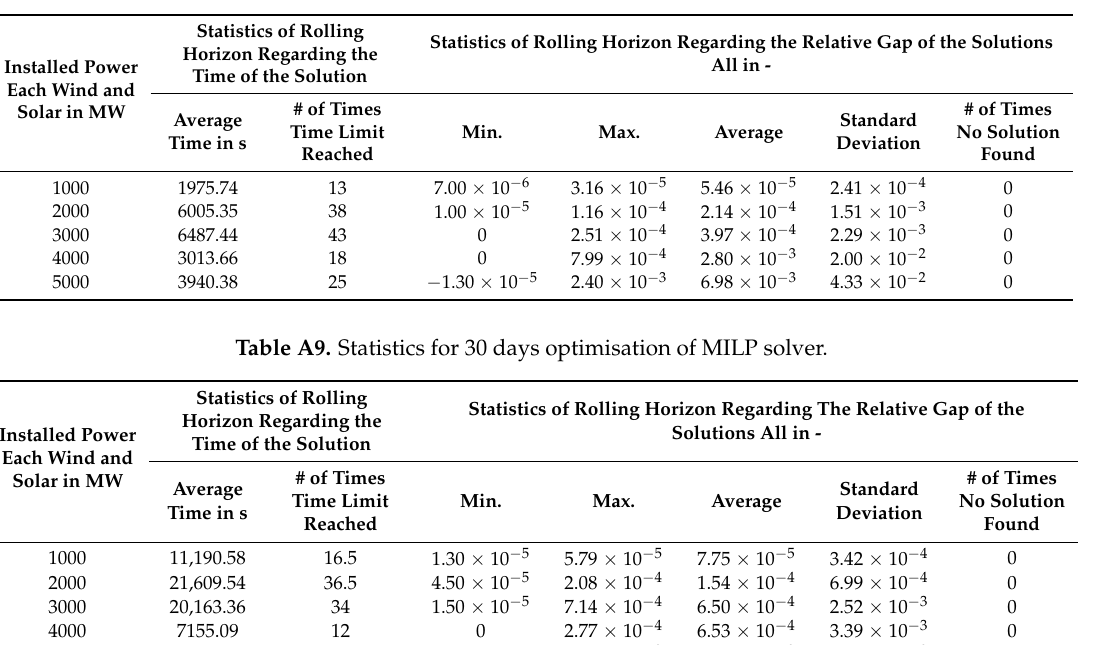
Table A8. Statistics for 14 days optimisation of MILP solver.